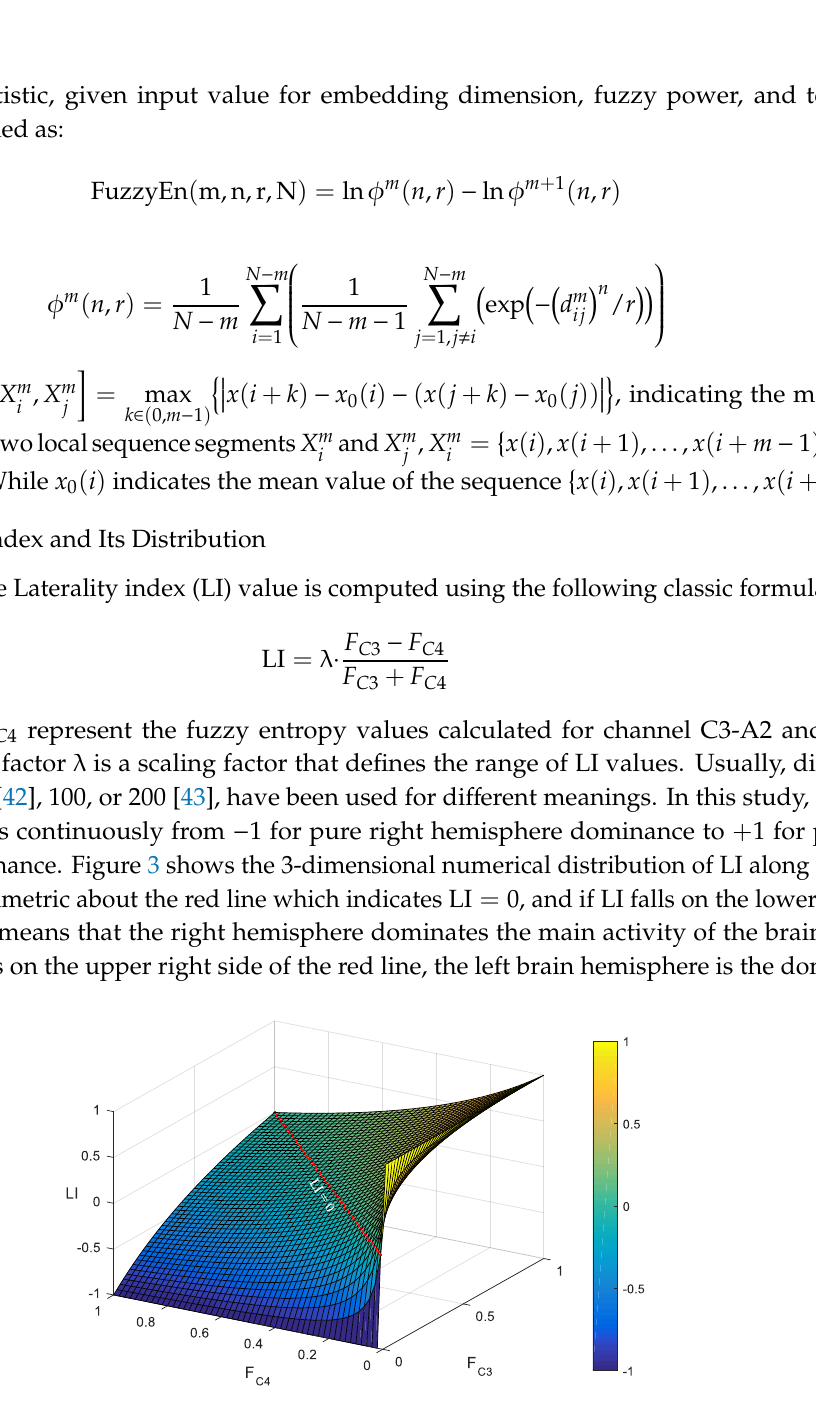
Figure 3. LI as a function of F C 3 and F C 4 (with λ = 1). The X -axis and Y -axis represent F C 3 and F C 4 respectively, and the Z -axis indicates LI.